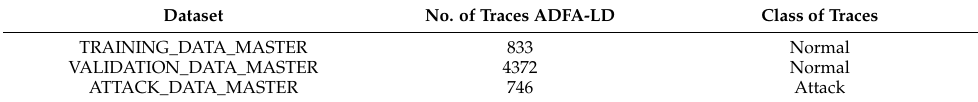
Table 9. ADFA-LD dataset composition based on binary classification of the types of system call traces.